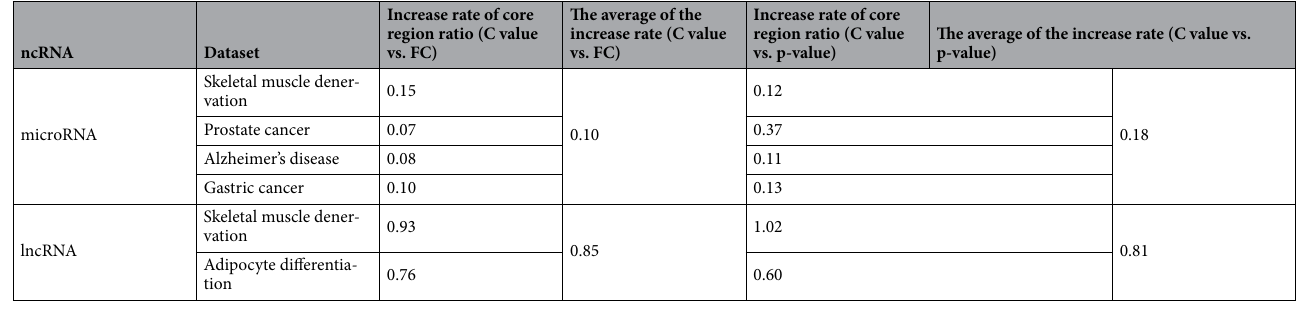
Table 7. Efficiency comparison of C value in PPI